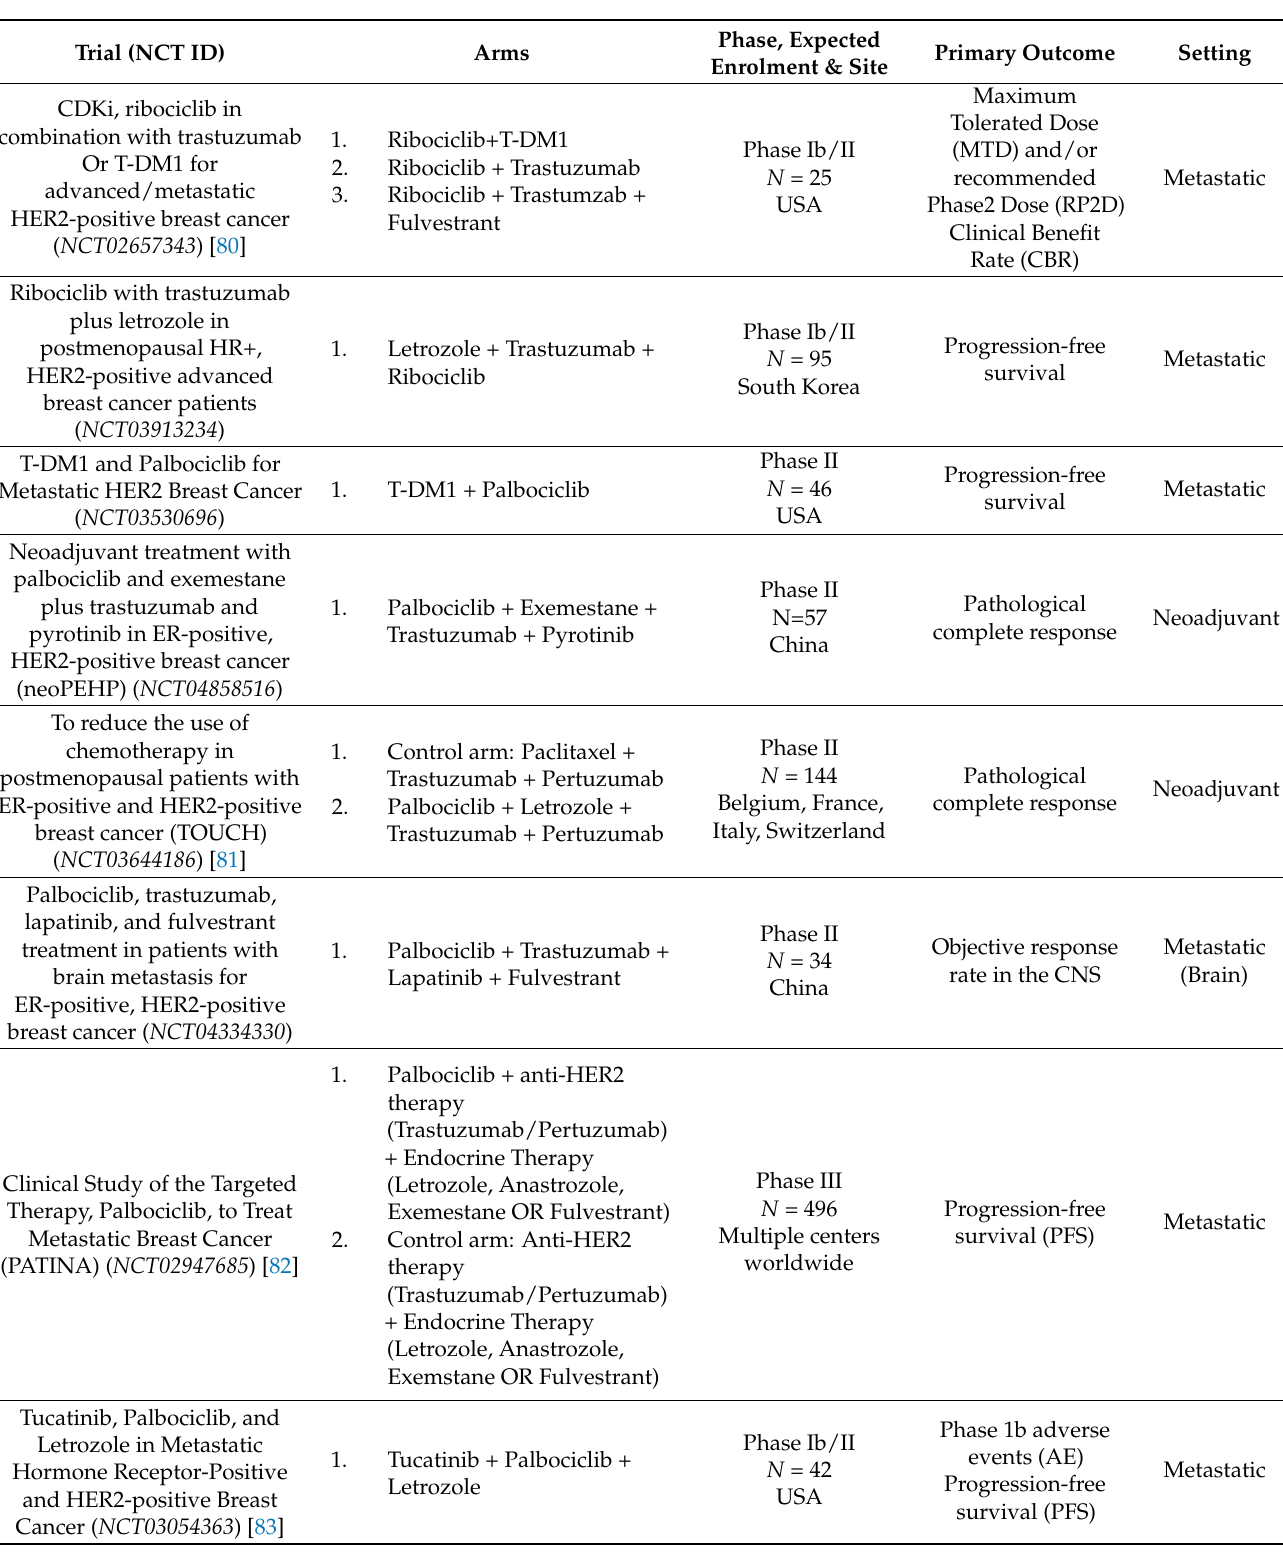
Table 2. Clinical trials with CDK4/6 inhibitors (CDKi) in HER2+ breast cancer